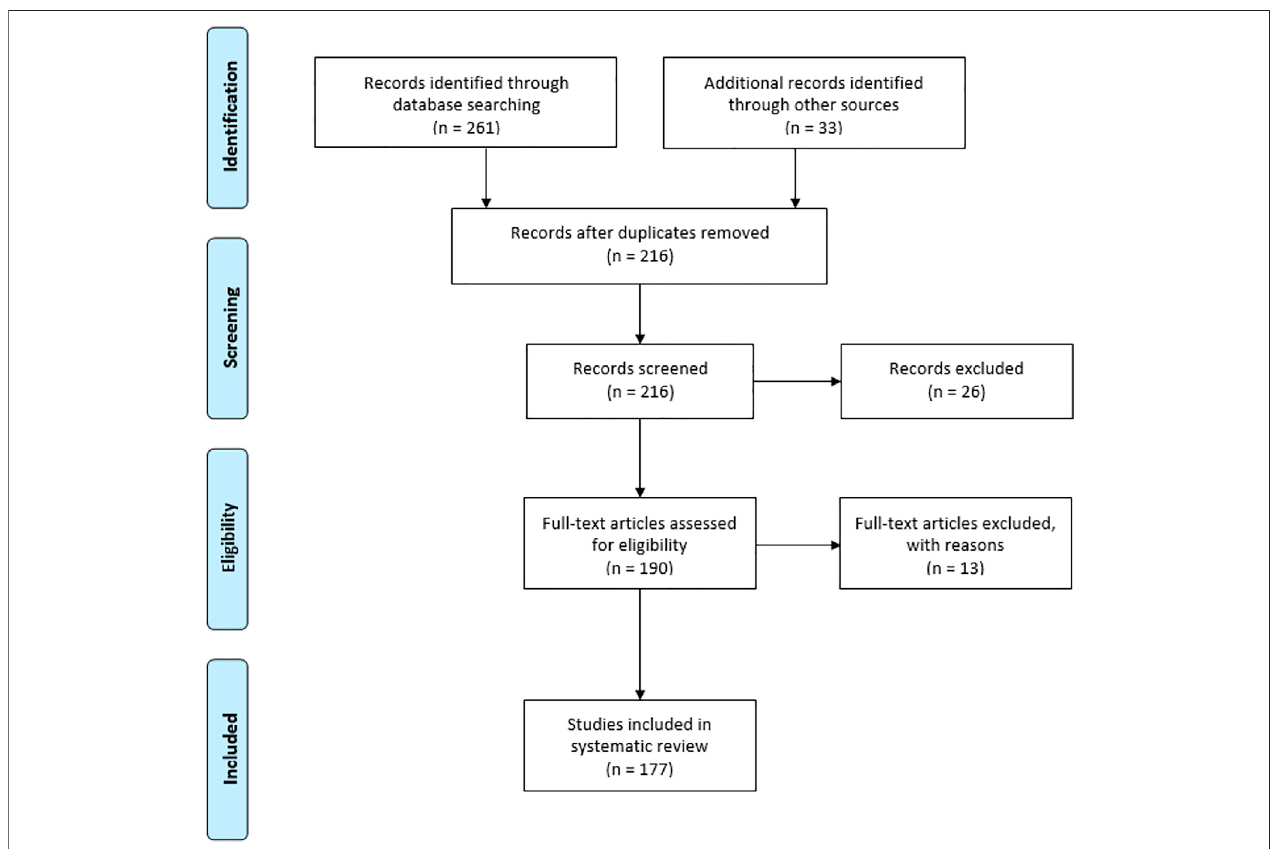
FIGURE 2 | Flow diagram of preferred reporting of items for systematic reviews and